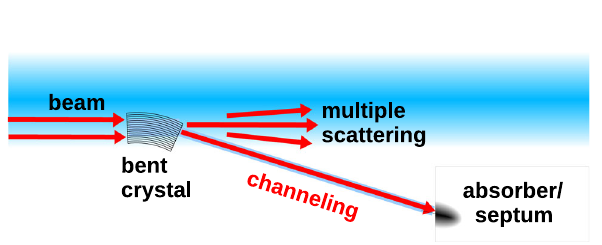
Fig. 3 Schematicillustrationofacrystal-basedcollimation/extraction. The bent crystal deflects the beam onto either an absorber or a septum magnet. A fraction of the beam is not captured under channeling